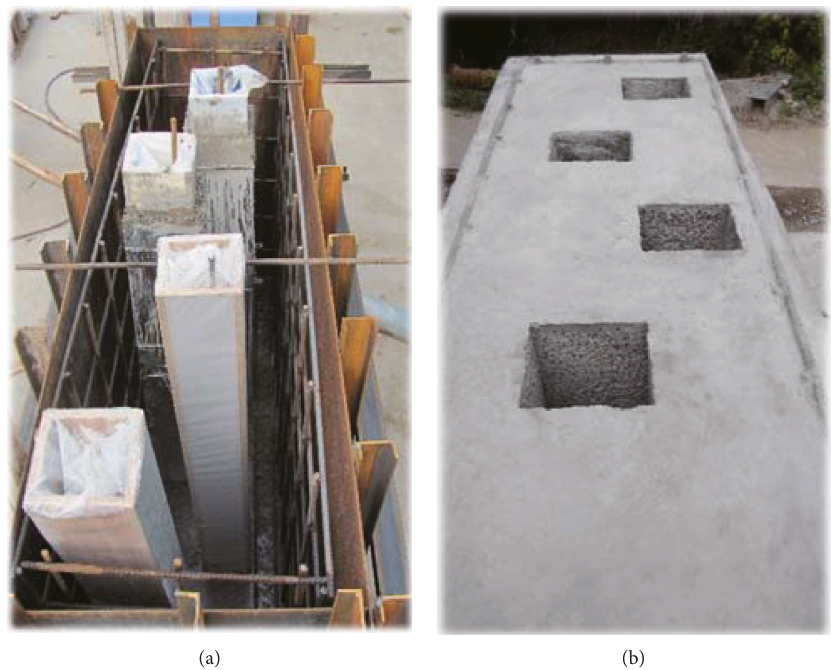
Figure 6: Concrete structure specimen construction site. (a) Pouring site. (b) Formed concrete slab.